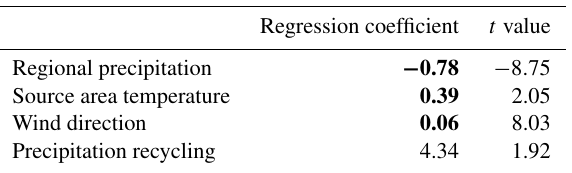
Table 3. Results of the multiple linear regression analysis. Signifi- cant relationships (P <0.01) are shown in